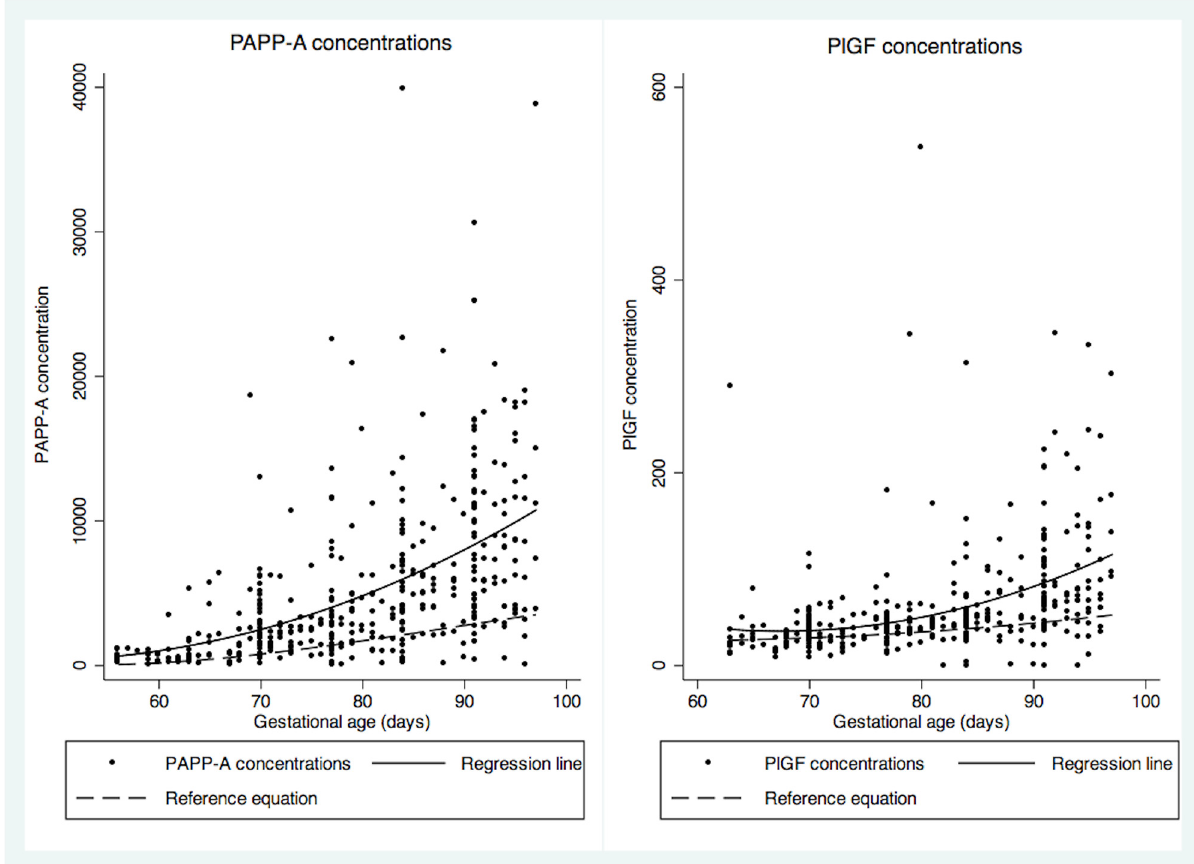
Fig 1. PAPP-A and PlGF concentrations scatterplot, with reference population equation and fitted regression line. Reference population equation PAPP-A: y = 12605.9606 – 552.53697 x + 7.42649 x 2 – 0.0278 x 3 ; fitted regression line PAPP-A: y = 10123 – 408.82 x + 4.2817 x 2 ; Reference population equation PlGF: y = 75.08 – 1.7769 x + 0.01589 x 2 ; fitted regression line PlGF: y = 448.25 – 12.247 x = 0.908 x 2